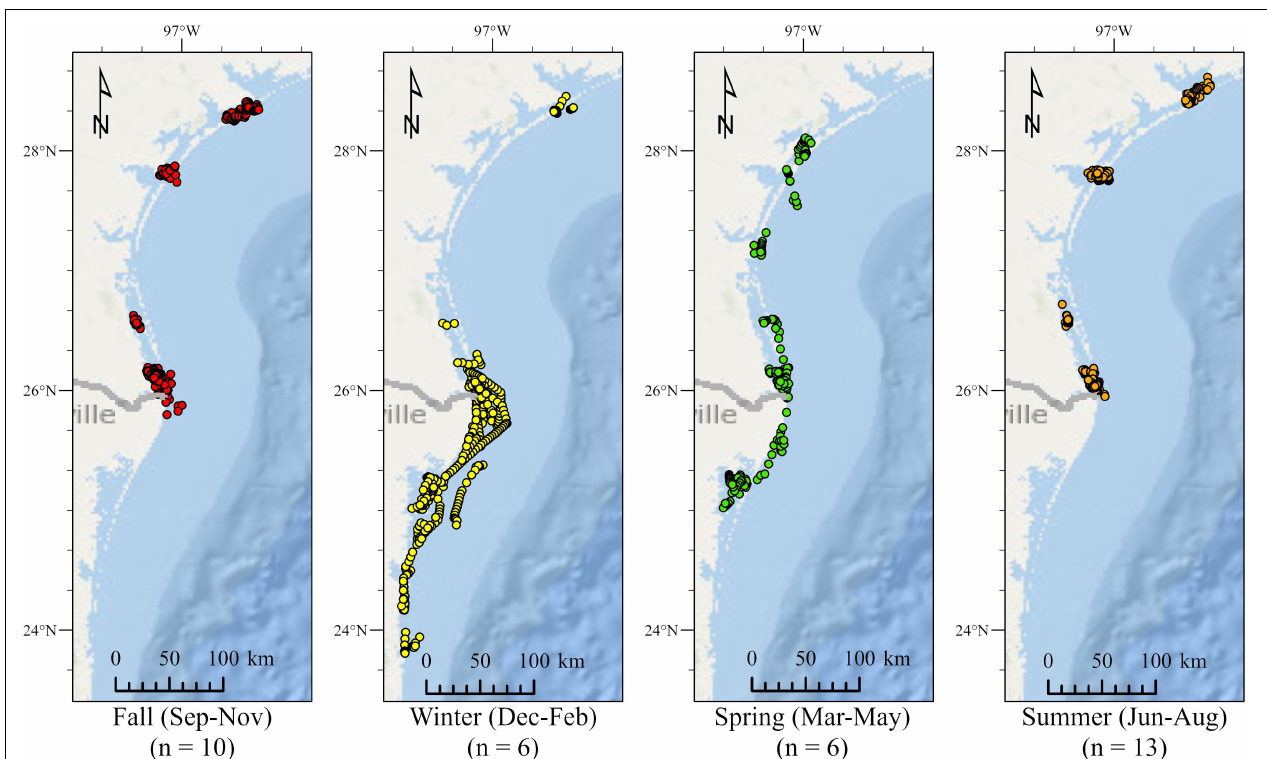
FIGURE 2 | Hierarchical switching state-space model (hSSM) mean seasonal daily locations of juvenile green turtles tracked in the northwestern Gulf of Mexico ( N = 15). Number of individuals tracked each season indicated below season headers. Fall (red) and summer (orange) locations were restricted to inland waters within Texas bays and estuaries. Winter (yellow) locations showed longest migrations in to the Laguna Madre in Mexico. Spring (green) locations were not as widely distributed as winter locations, but extended into Mexican